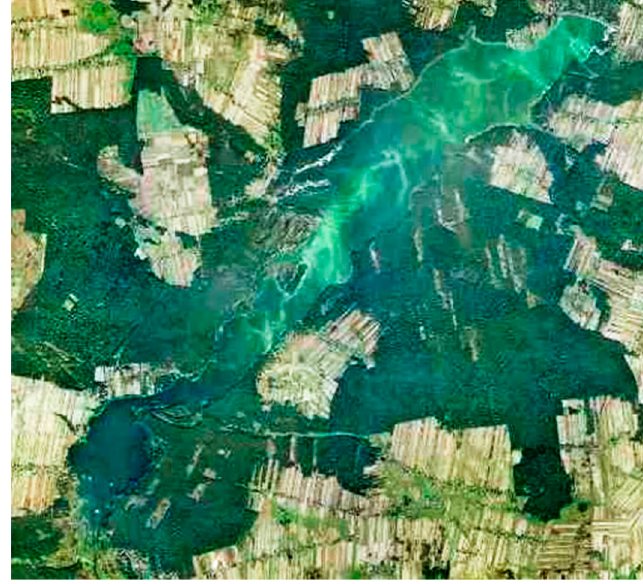
Figure 13. Satellite map of the Sulejów Reservoir (Source: geoportal.gov.pl).